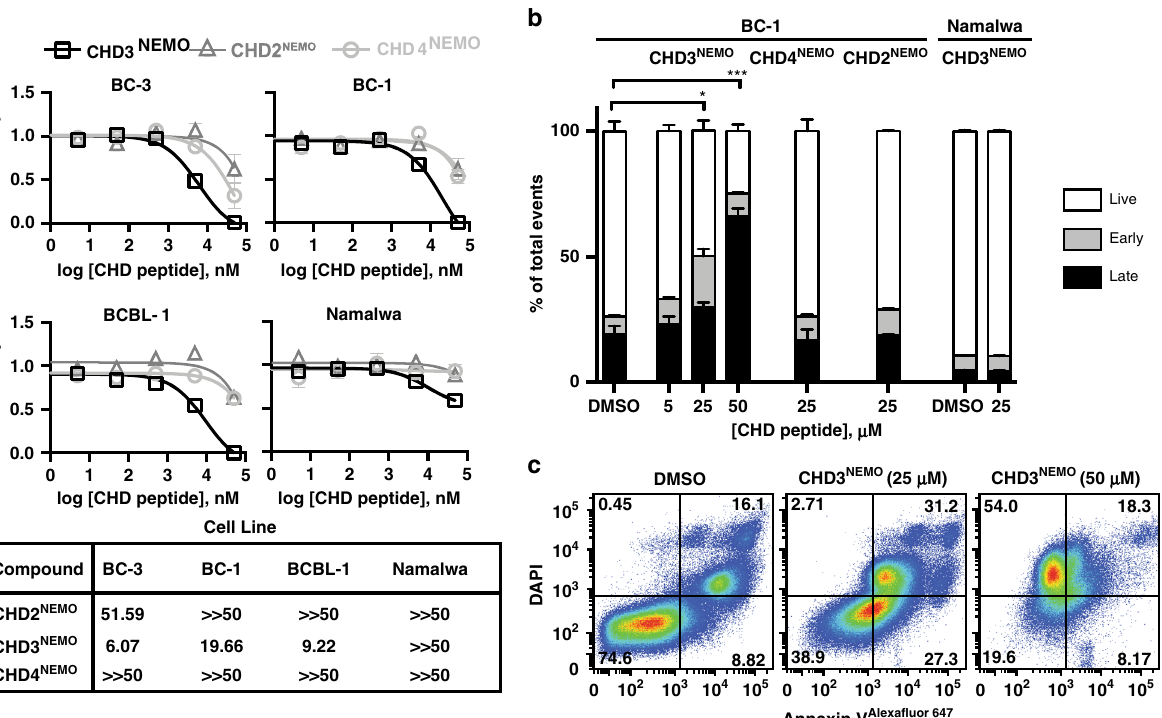
Fig. 5 CHD3 NEMO induces cell death in vFLIP-expressing PEL cell lines. a CHD3 NEMO but not CHD2 NEMO or CHD4 NEMO controls induces cell death in a panel of PEL cell lines. vFLIP ( − ) Namalwa cell line was used as a control. BC-3, BCBL-1, BC-1, and Namalwa cells were treated with increasing concentrations of CHD2 NEMO , CHD3 NEMO , CHD4 NEMO , and cytotoxicity was assayed using the CellTiter-Glo assay at t = 24 h and t = 72 h, respectively. Data represents mean ± SEM of ( n = 3) independent experiments performed in duplicates. The IC 50 s ( µ M) of the CHDs in the tested cell lines are displayed in the table below the graphs. b – c Flow cytometry analysis showing that CHD3 NEMO induces apoptosis in vFLIP ( + ) BC-1 PEL cell line, but not vFLIP ( − ) Namalwa. CHD2 NEMO and CHD4 NEMO had no effect. BC-1 cells were treated with DMSO, 5 µ M, 25 µ M or 50 µ M of CHD3 NEMO for 48 h. After staining for DAPI and Annexin V, cells were examined using fl ow cytometry. Results were quanti fi ed into percentages of live (Annexin V − , DAPI − ), early apoptotic cells (Annexin V + ) or late apoptotic cells (Annexin V + / DAPI + and DAPI + ). Results shown are the mean ± SEM of ( n = 3) independent experiments. Statistical analysis was performed using two-tailed unpaired t -test comparing treated samples to DMSO control. DMSO vs 25 μ M CHD3 NEMO early apoptotic population p = 0.0124, DMSO versus 50 μ M CHD3 NEMO late apoptotic p = 0.0010 (* p ≤ 0.05, *** p ≤ 0.001 respectively). One-way ANOVA analysis was performed comparing 25 μ M dose of each of CHD2 NEMO , CHD3 NEMO , CHD4 NEMO peptides and was found to be signi fi cant with p = 0.0087, ** p ≤